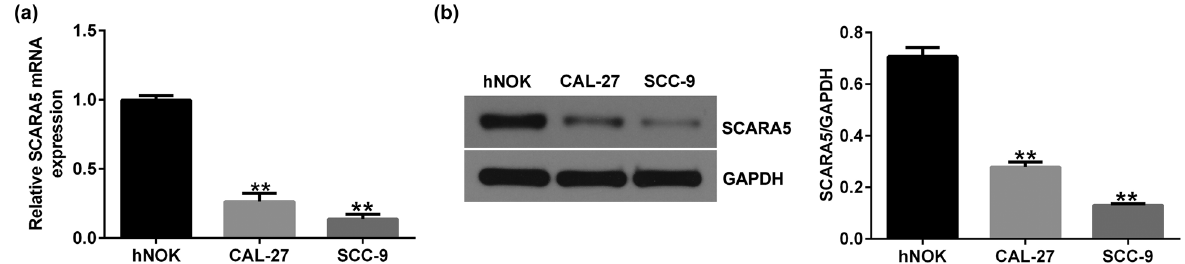
Figure 1: SCARA5 expression was downregulated in CAL - 27 and SCC - 9 cells. ( a ) qRT - PCR assay of SCARA5 gene expression in hNOK, CAL - 27, and SCC - 9 cells. ( b ) Western blot assay of SCARA5 protein expression, and SCARA5/GAPDH was calculated. ** p < 0.01 vs hNOK.